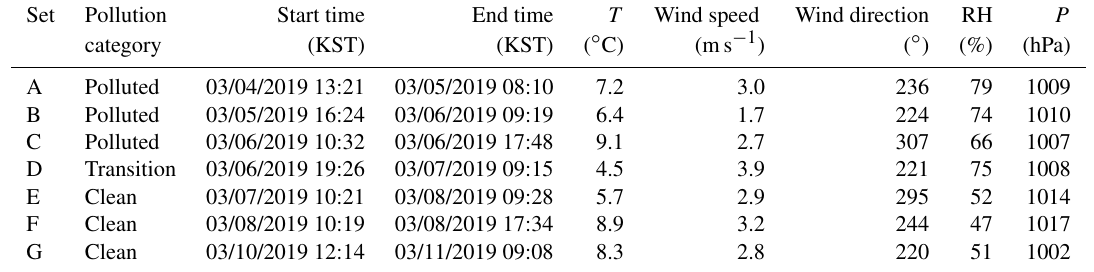
Table 2. Summary of the DLPI + sample sets including sample set name, pollution category, the start and end date in Korea standard time (KST: UTC + 9h), and the sample averages of T , wind speed and direction, RH, and P . Sample flow rate was 9.71Lmin − 1 for all sample